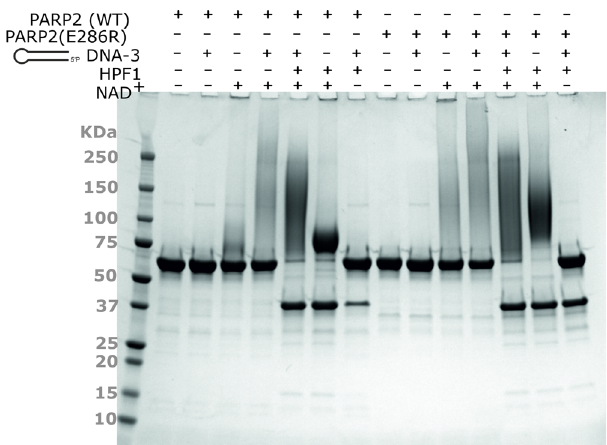
Fig. 5 PARP2 activity assay with HPF1. Binding of HPF1 changes the nature of the resulting PAR. Reactions contained 5 µ g PARP2 and equimolar concentrations of HPF1 and 5 ′ phosphorylated hairpin oligonucleotide as well as 1 mM NAD + to allow visualization of protein smearing due to poly- ADP-ribosylation. The experiment was repeated with similar